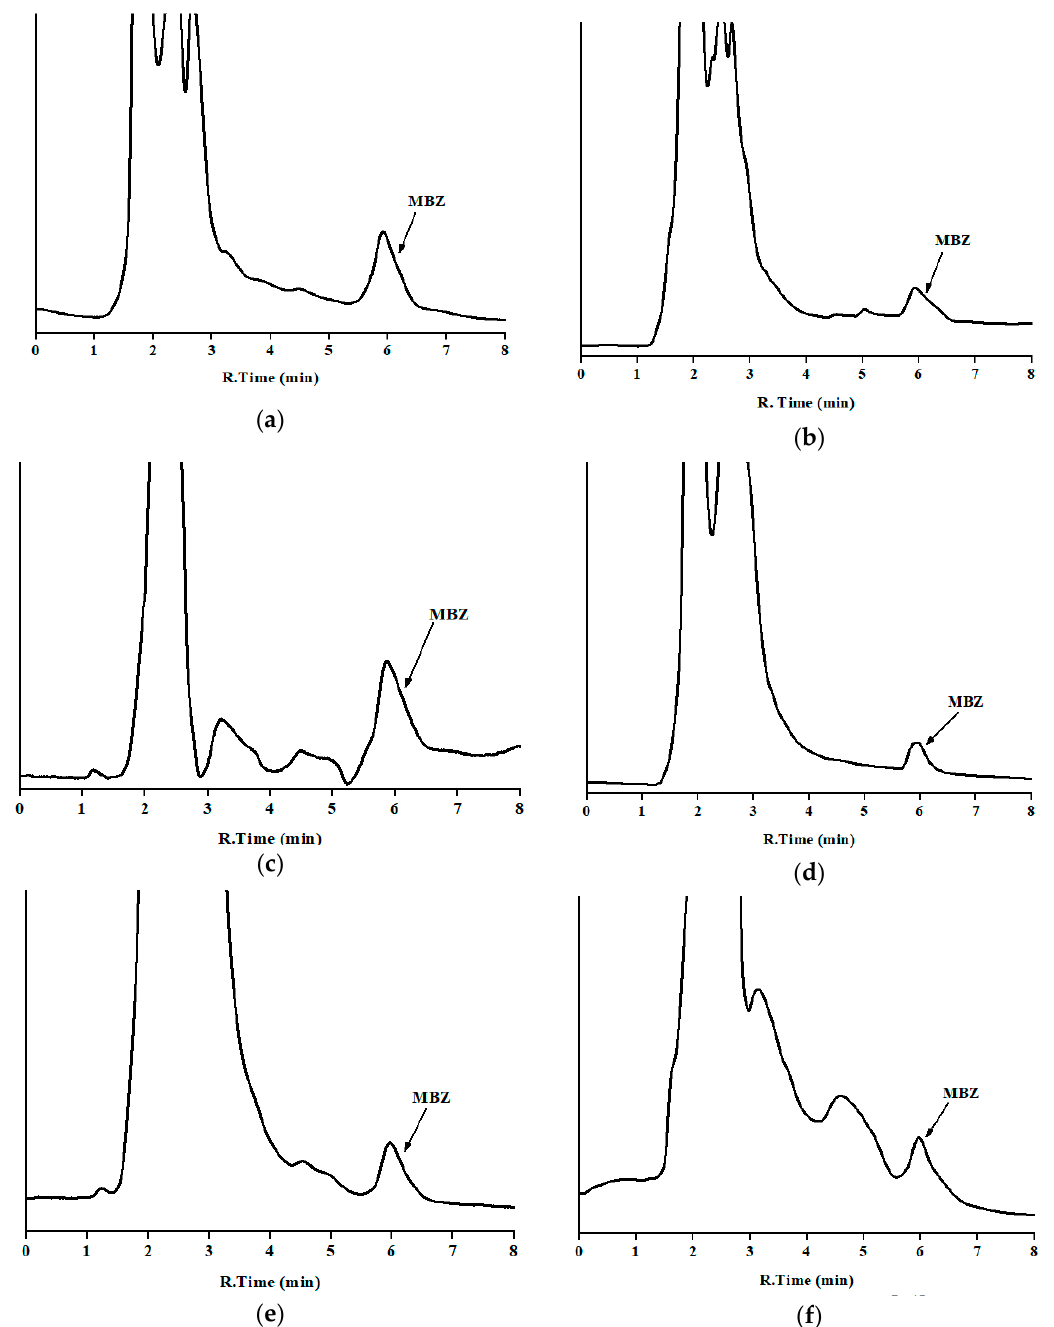
Figure 4. Chromatograms of incurred samples in the optimum chromatographic conditions: ( a ) milk; ( b ) cheese; ( c ) butter; ( d ) curd; ( e ) urine; and ( f ) dung (y-axis is the absorbance in arbitrary units, and the same scale applies for Figures 2–4). Corresponding concentration are in Table 3 (set 1).